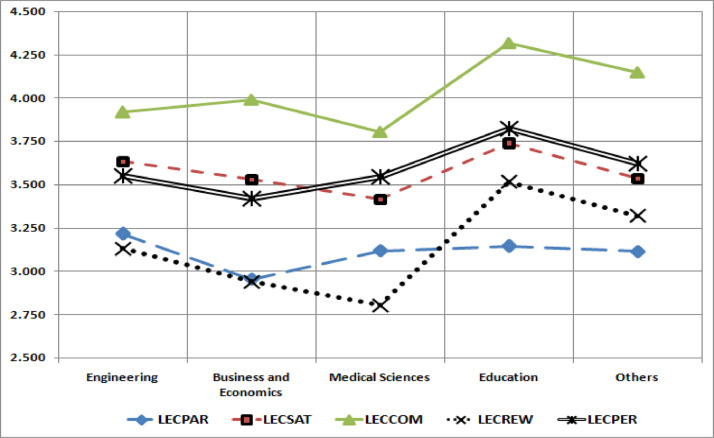
Mean Comparison of Lecturer Rating Based on School Backgrounds